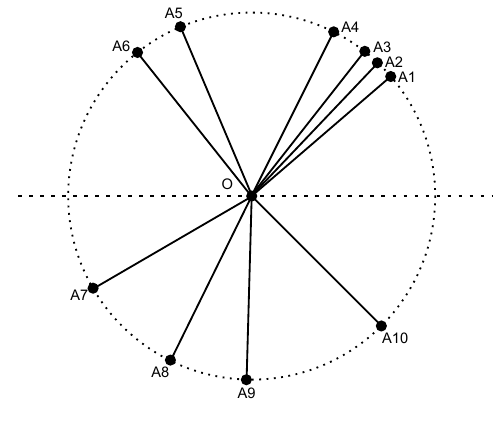
Figure 10. The generated topology for Experiment 1.